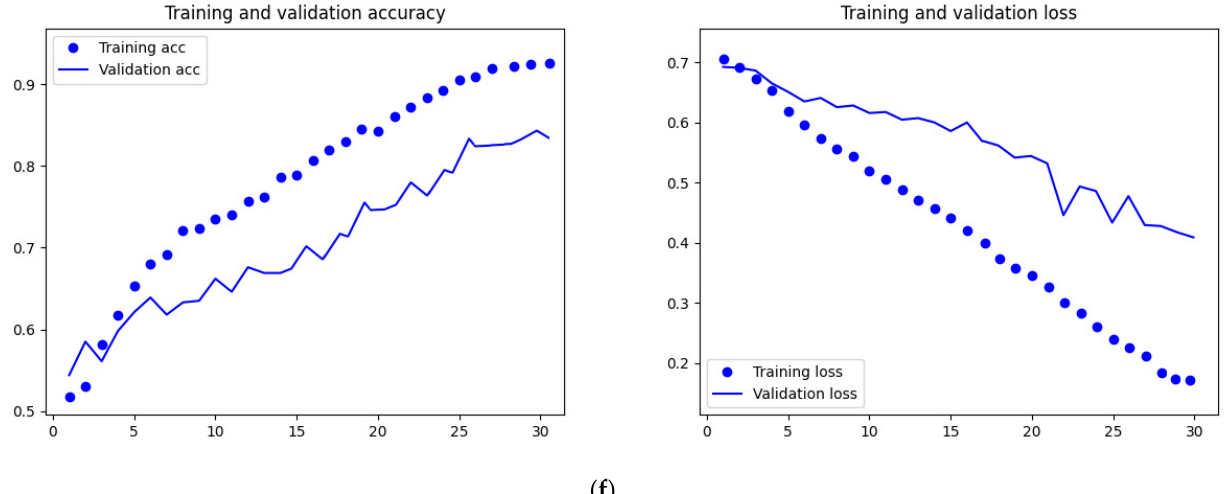
Figure 4. Visualization of loss function curves and learning accuracy and validation for the created